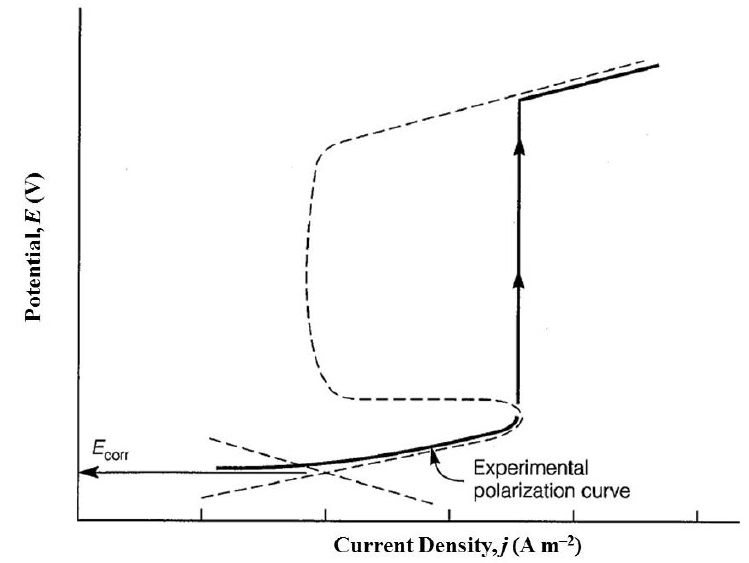
Figure 7. Comparison between potentiostatic (dashed line) and galvanostatic (bold line) anodic polarization curves. The x-axis is in logarithmic scale.